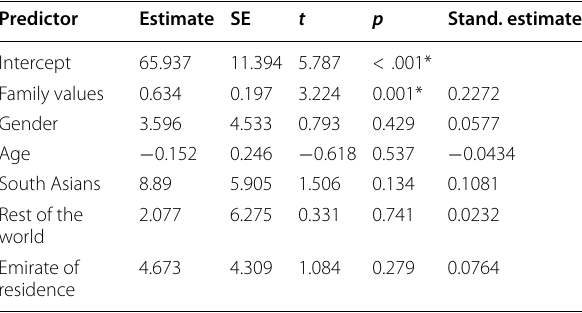
Table 4 Model coefficients — attitudes towards mental health